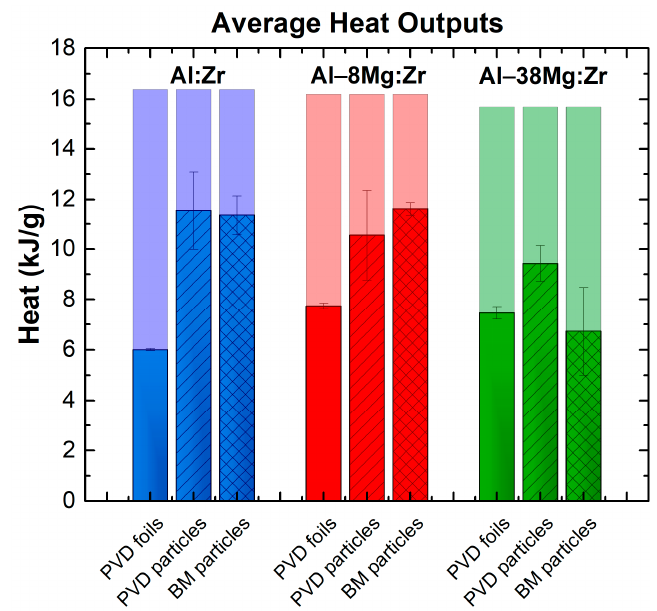
Figure 4. Heat output in 1 atm of O 2 for 40 µ m thick PVD and ball milled (BM) particles, compared with data for 40 µ m thick PVD foils, also in 1 atm of O 2 , for each of the three chemistries of interest. Theoretical heat maxima are denoted by lighter background bars. Heat data for PVD foils were originally presented in [46].